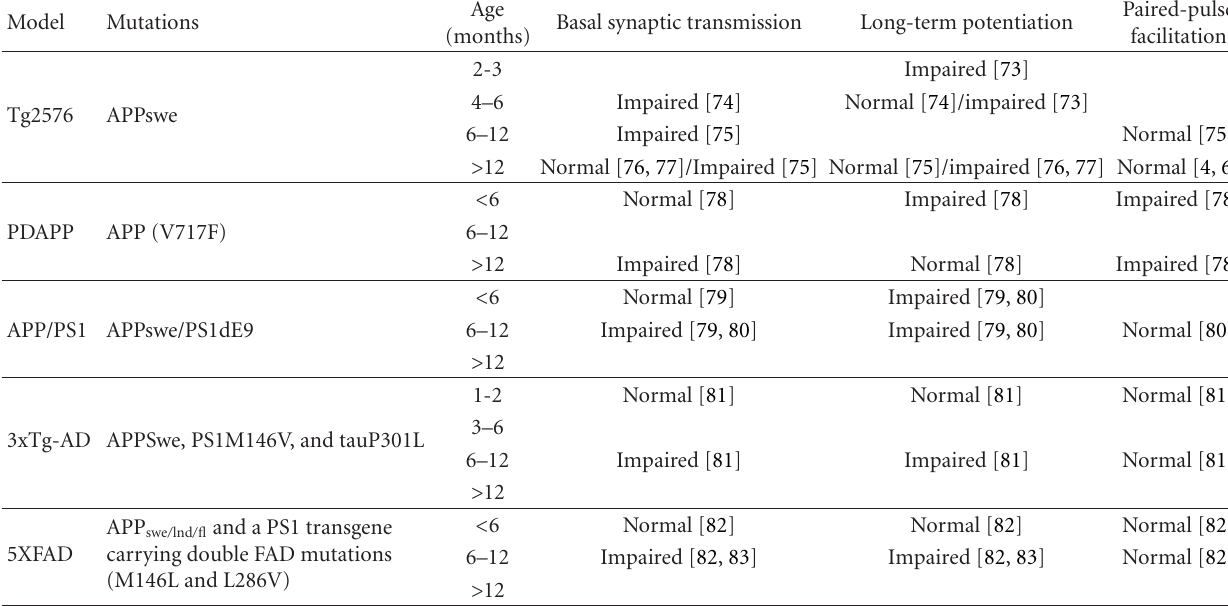
Table 1: Progressive synaptic malfunction AD transgenic